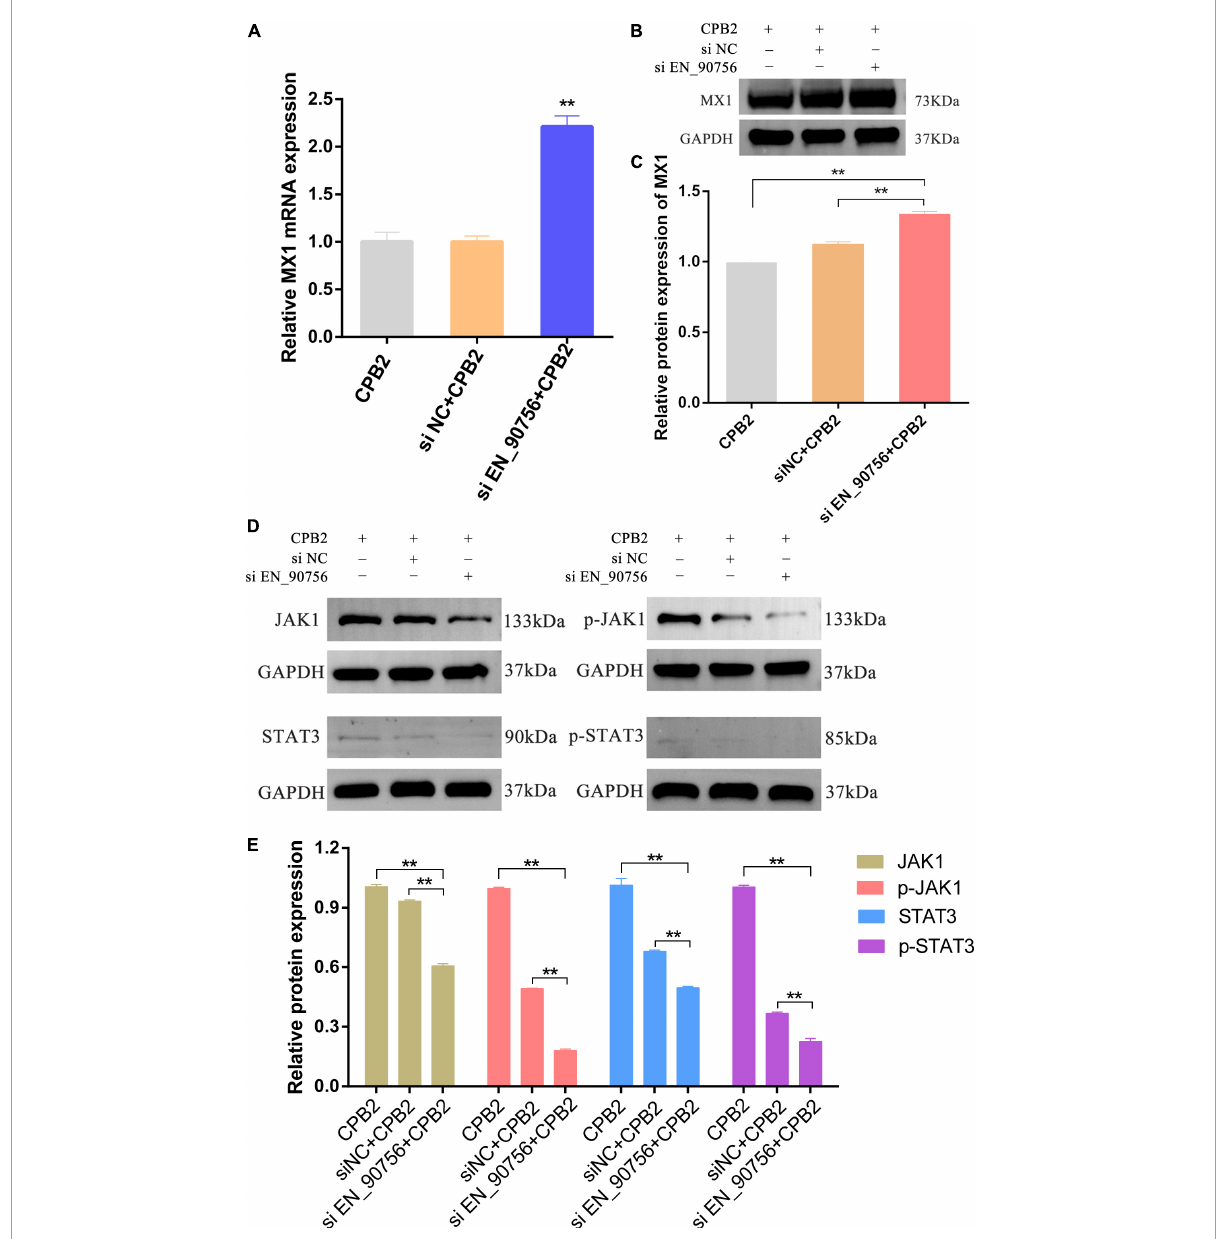
FIGURE6 Inhibition of long non-coding RNA (lncRNA) EN-90756 promoted MX1 expression and suppressed the Janus kinase (JAK)-signal transducer and activator of transcription (STAT) signaling pathway. The mRNA expression (A) and protein levels (B,C) of the target gene MX1 in Clostridium perfringens beta2 (CPB2)-induced intestinal porcine epithelial cell line-J2 (IPEC-J2) cells before and after lncRNA EN-90756 inhibition. (D,E) Western blotting analysis of JAK1, p-JAK1, STAT3, and p-STAT3 protein levels in IPEC-J2 cells after CPB2 stimulation by lncRNA EN-90756 inhibition. ** p <